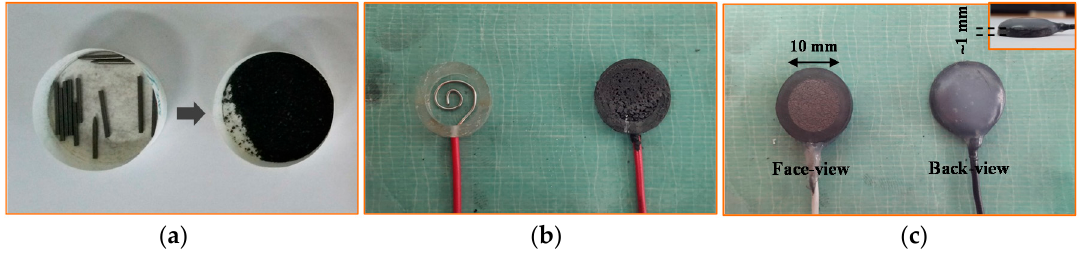
Figure 3. ( a ) Pencil lead grinding powder; ( b ) small piece of acrylic tube within electrical wire being placed at the bottom; and ( c ) pencil lead powder-type electrode.